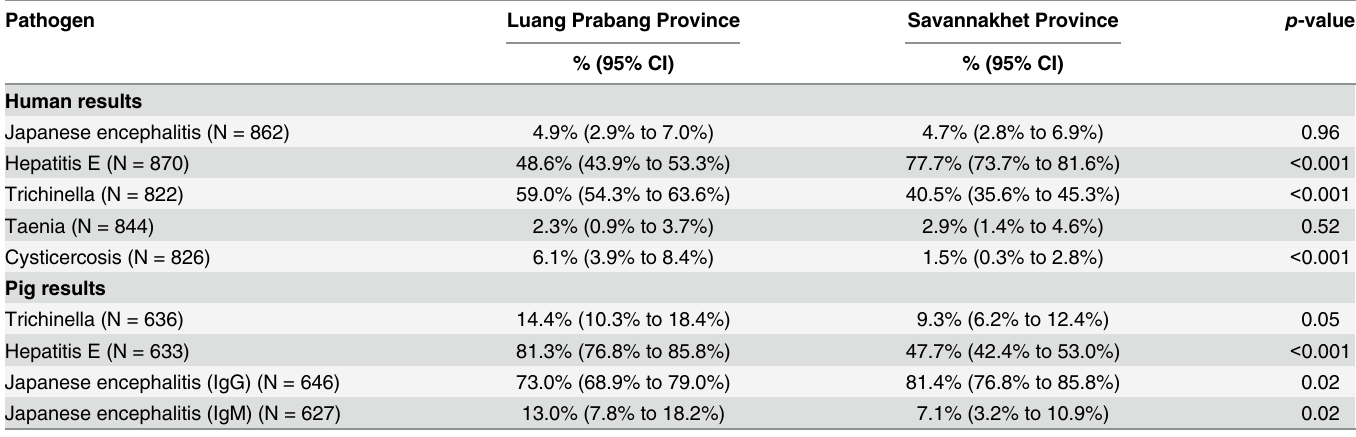
Table 1. Comparison of seroprevalence estimates (with 95% confidence intervals) for the selected of zoonotic pathogens in humans and percent- age of pigs testing seropositive in Lao PDR, according to Province ( * p-values refer to the results of chi-square